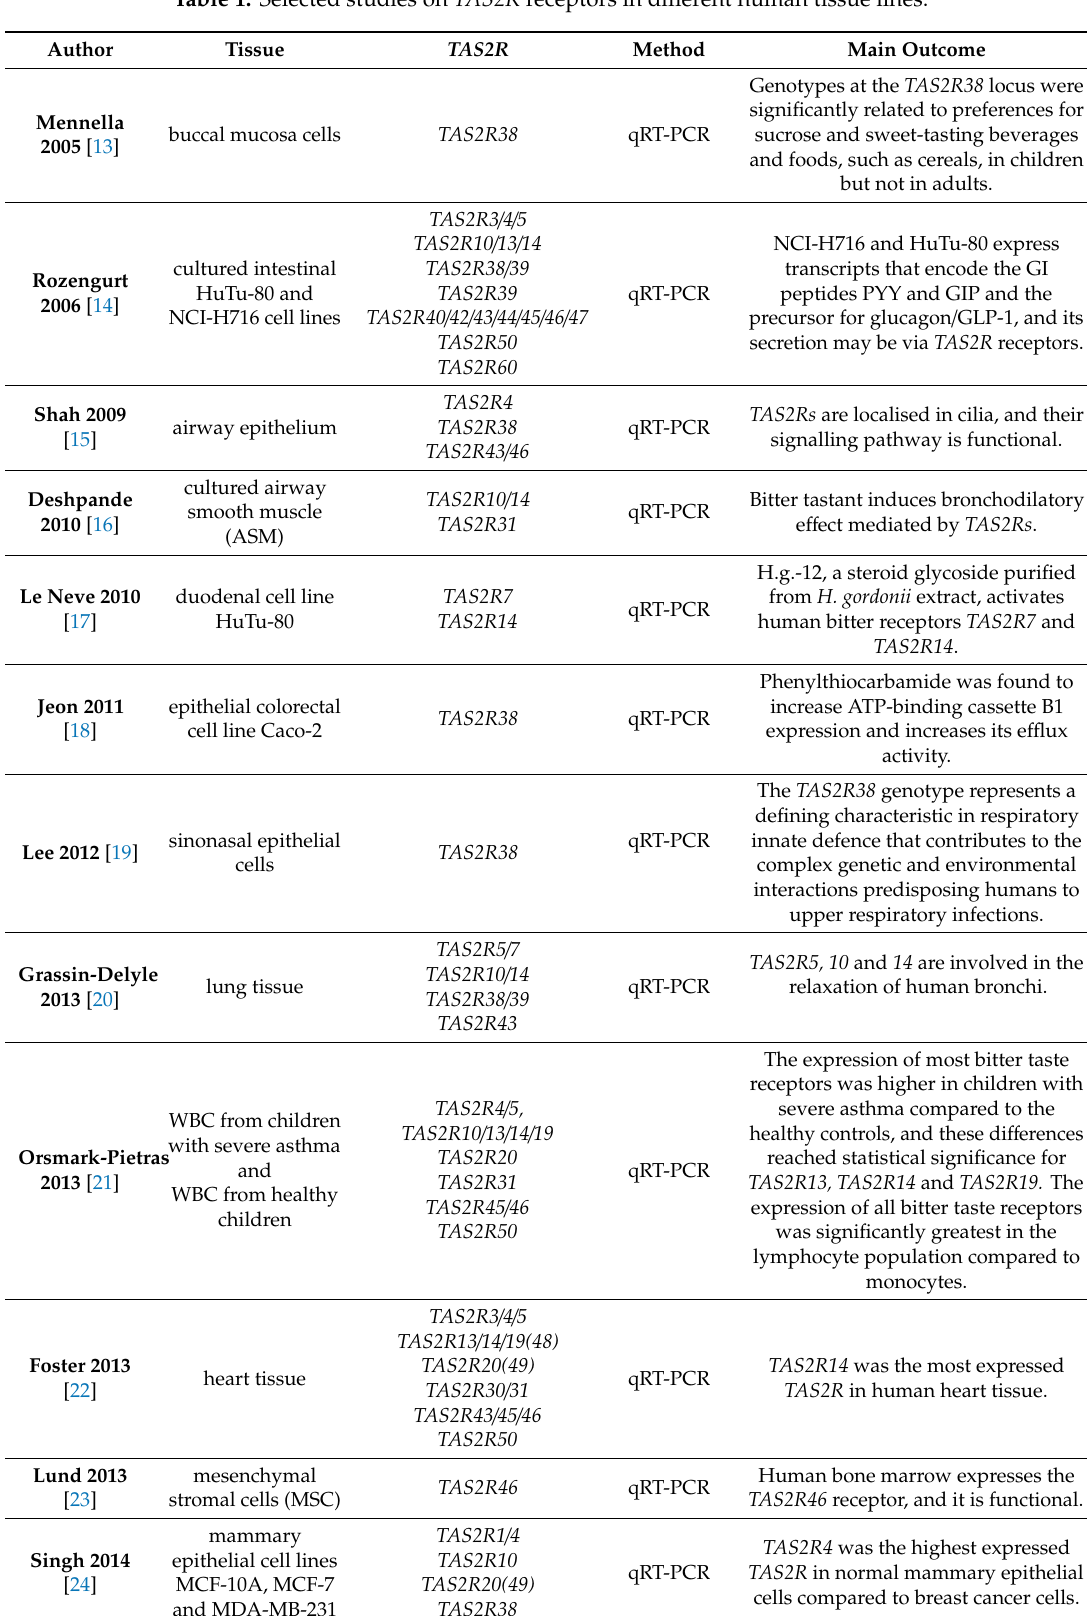
Table 1. Selected studies on TAS2R receptors in di ff erent human tissue